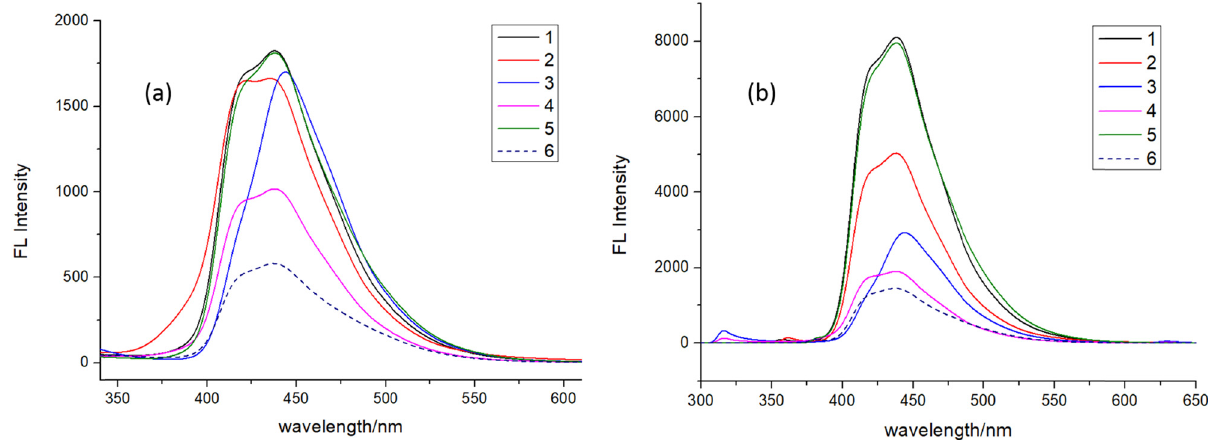
Figure 8: Fluorescence spectra of the complexes in CH 2 Cl 2 ( 3.0 × 10 − 5 M ) . ( a ) At λ ex = 310 nm and ( b ) at λ ex = 352 nm ( 1 ) , 356 nm ( 2 ) , 377 nm ( 3 ) , 356 nm ( 4 ) , 378 nm ( 5 ) , and 376 nm ( 6 ) .